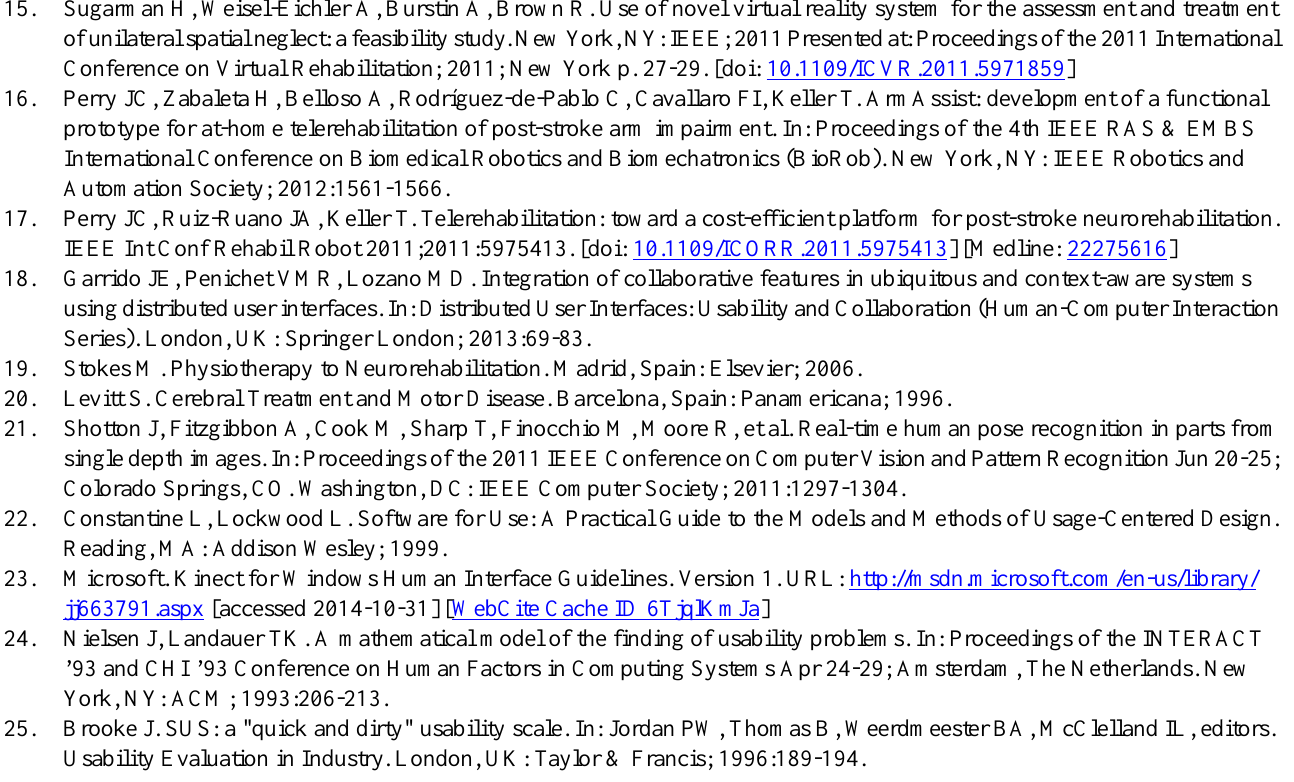
Abbreviations SDK: software development kit SUS: System Usability